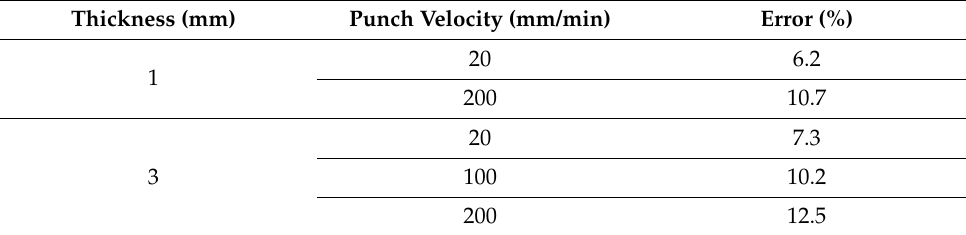
Figure 12. Comparing the experimental and simulated FLDs for a 3 mm-thick AA 6061 sheet at 200 mm/min speed. Table 3. Average errors between the experimental and the simulation diagrams.